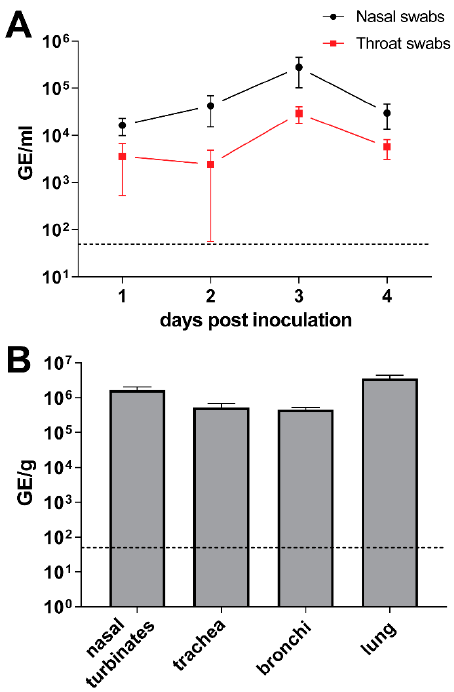
Figure 4. Middle East respiratory syndrome coronavirus (MERS-CoV) infects the upper and lower respiratory tract of Netherland dwarf rabbits. The amount of viral RNA in the nasal and throat swabs ( A ) as well as in the respiratory tract tissues ( B ) are displayed in genome equivalents per mL (GE/mL) and genome equivalents per gram tissues (GE/g), respectively. Dashed lines depict the detection limit of the assays. All error bars represent standard error of means.